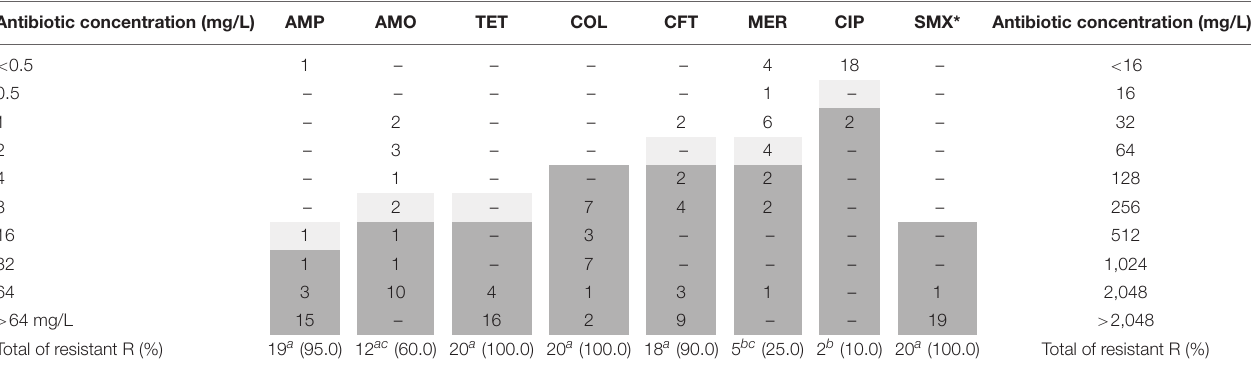
TABLE 3 | Distribution of MIC and resistance index of S H. Antibiotic concentration (mg/L)